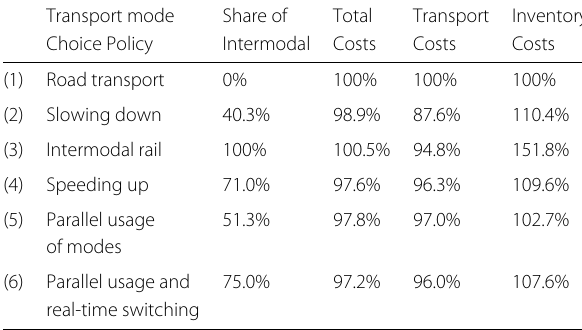
Table 3 Simulation results averaged over the 13 considered